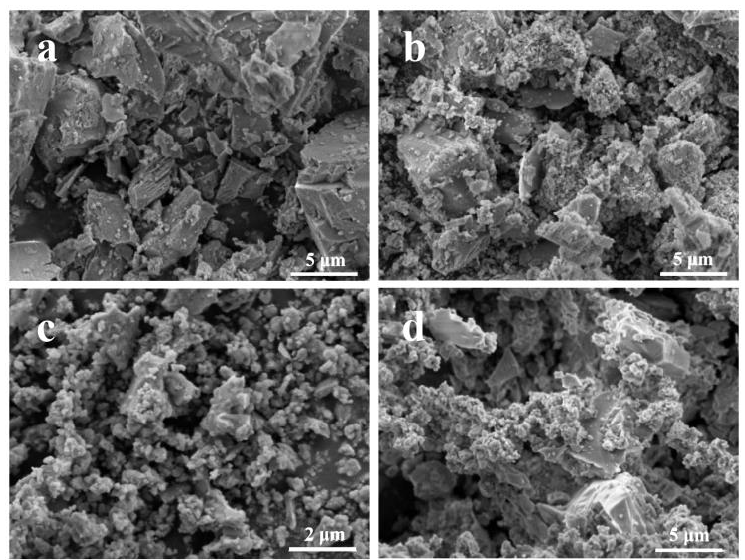
Figure 6. SEM photos of lead–zinc tailings after heat treatment at different temperatures [101]: ( a ) raw state; ( b ) 800 ℃ ; ( c ) 1000 ℃ ; ( d ) 1200 ℃ .